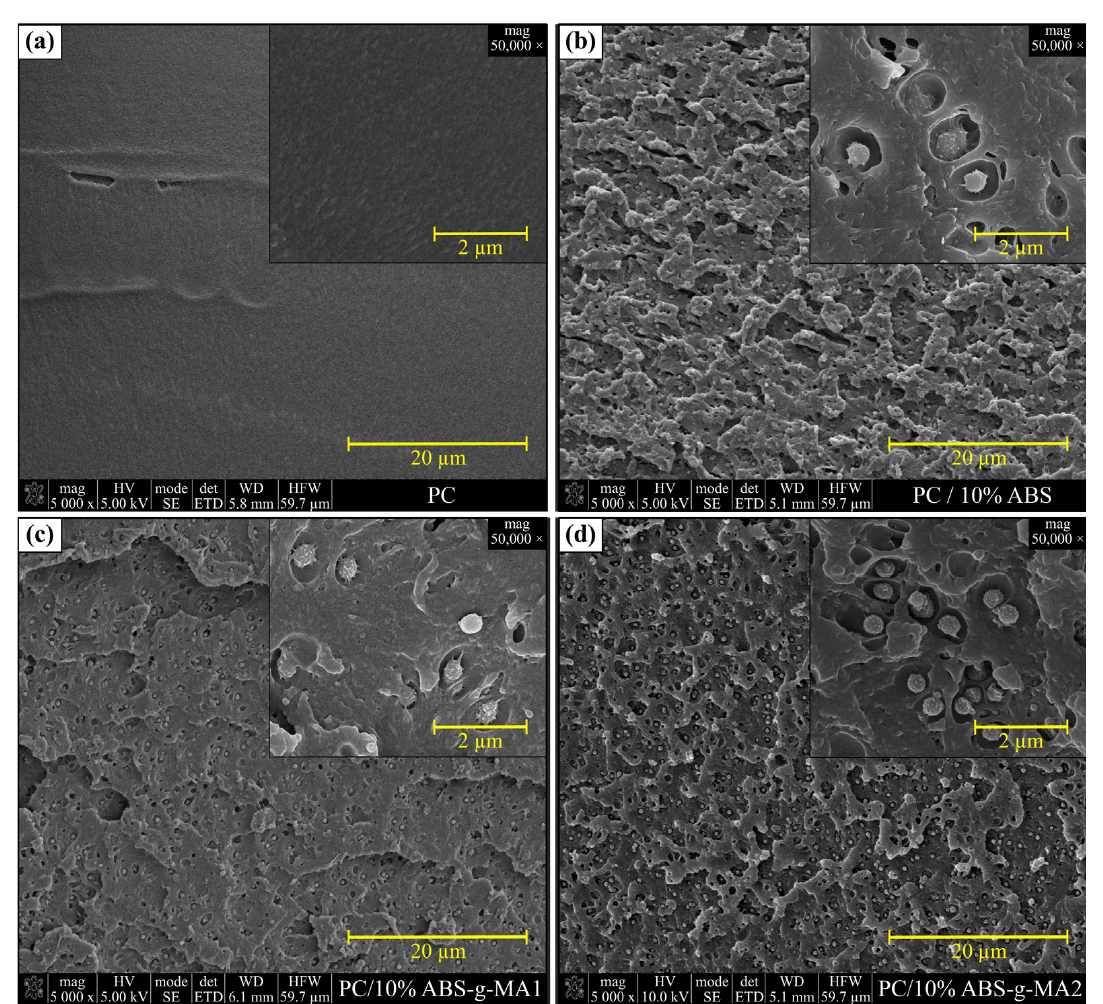
Figure 4. SEM micrographs of cryogenic fractured tensile specimens: ( a ) PC, ( b ) PC/10%ABS, ( c ) PC/10%ABS - g - MA1 , and ( d ) PC/10% ABS - g - MA2 blends.